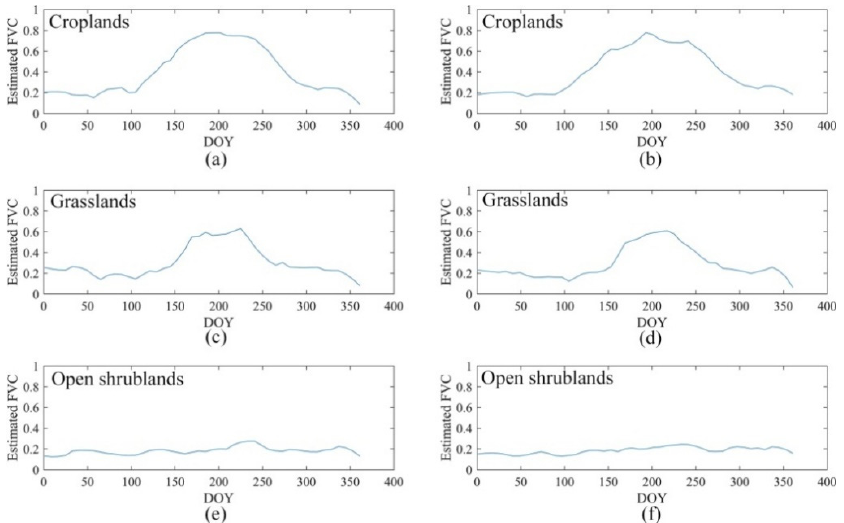
Figure 6. Temporal profiles of the FVC estimations by the proposed algorithm over different vege- tation types in 2015 ( a , b : croplands, c , d : grasslands, e , f : open shrublands).